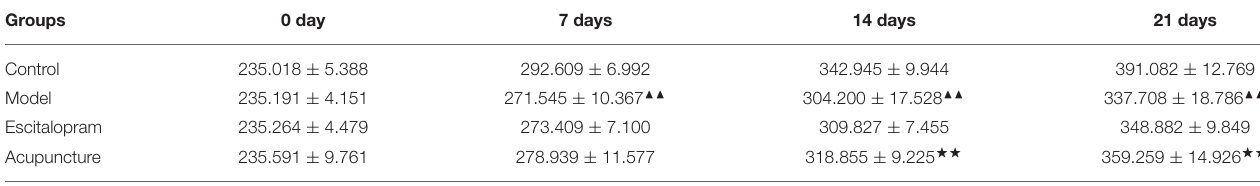
TABLE 1 | Effects of acupuncture on the changes of body weight of CRS rats. Groups